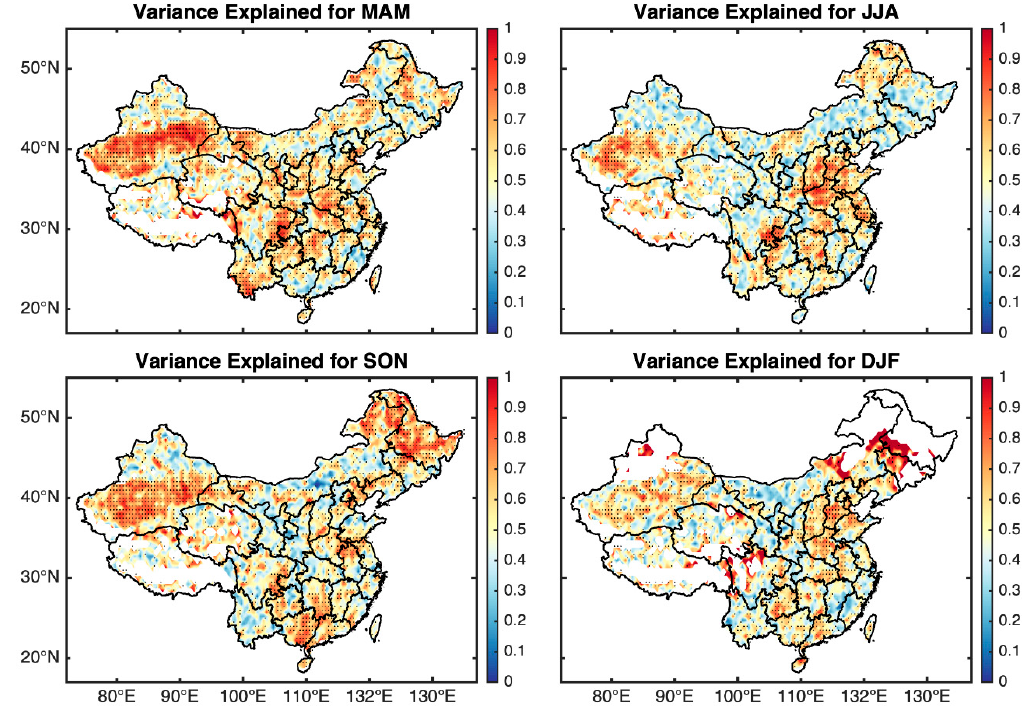
Figure 13. Variance explained by the seasonal regression model.